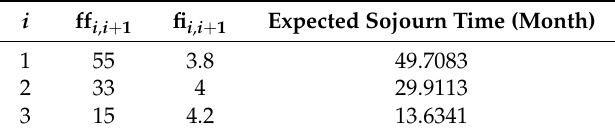
Table 3. Values of the scale parameters α i , i + 1 , shape parameters β i , i + 1 and expected sojourn time in each degradation state.